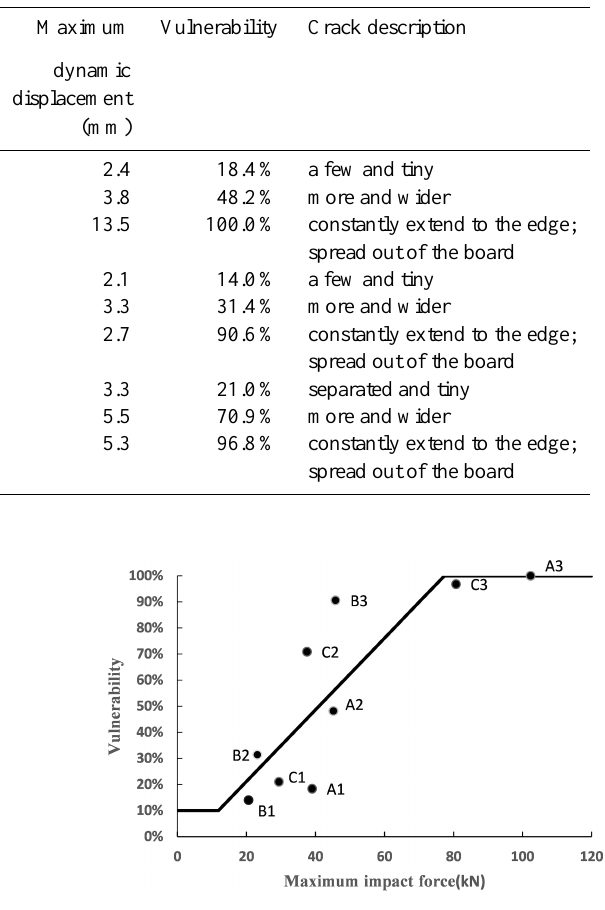
Figure 7. Vulnerability curve with maximum impact